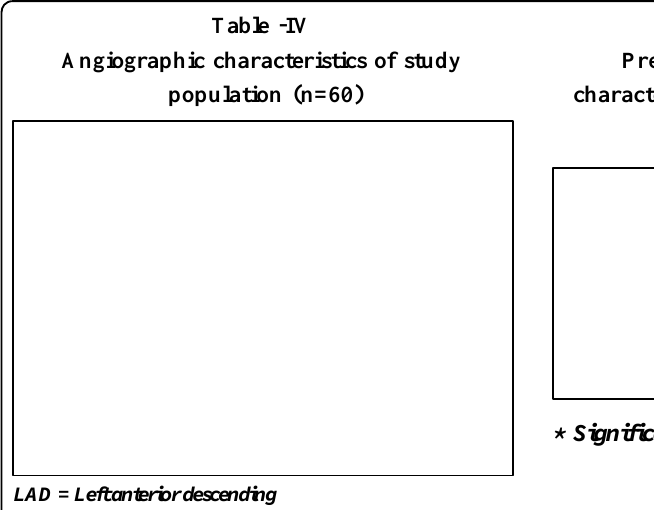
Pre-exercise electrocardiographic characteristics of true-positive versus true-